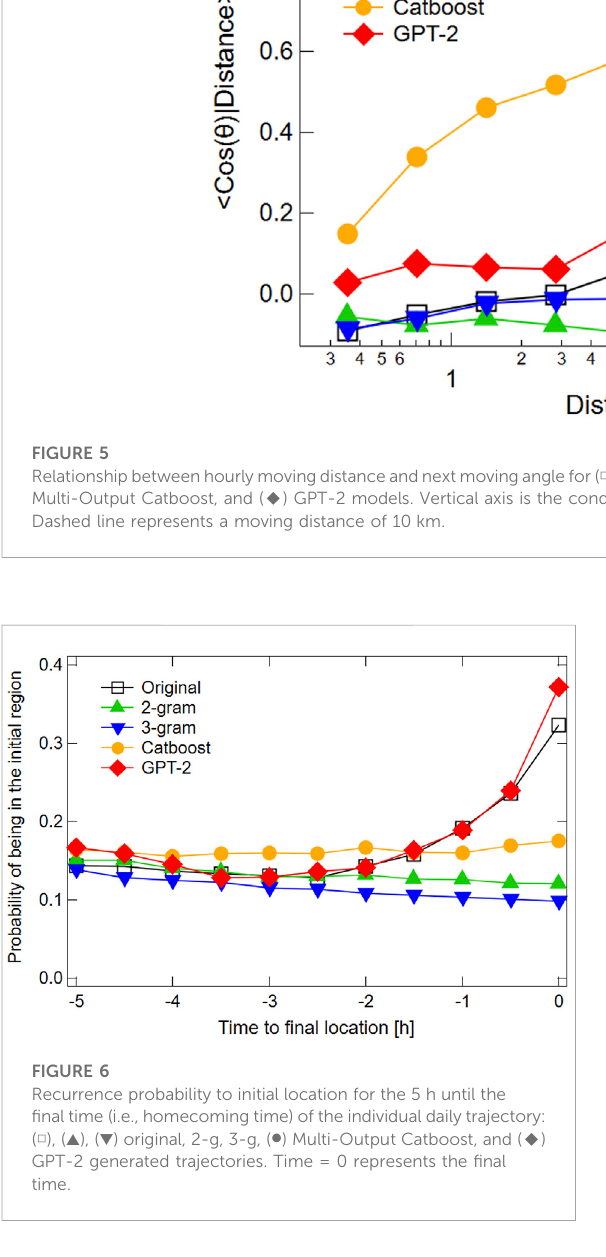
(cid:129) ) Multi-Output Catboost, and ( A )